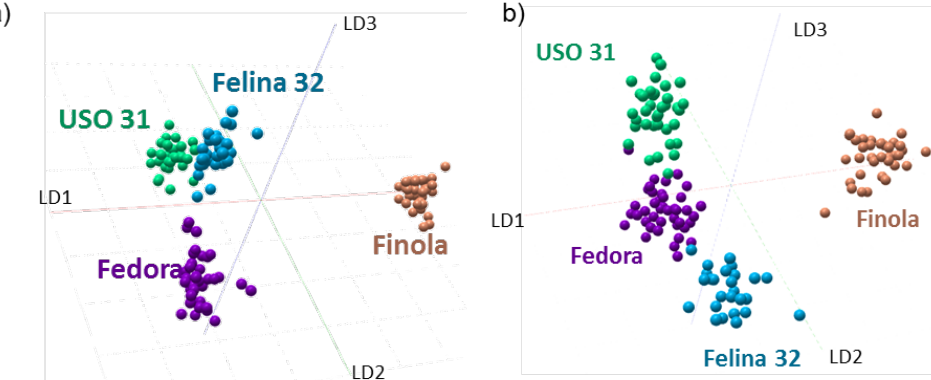
Figure 3. Multivariate statistical analysis of the molecular profiles from different plant organs com- bining all cultivars. ( a ) PCA plot and ( b ) PCA loading plot of 4 plant organs (flowers, bulbs, sugar leaves, and fan leaves) from all cultivars. ( c ) PC1 loading plot showing the highest variance between the flower (rose), bulb (purple), sugar leaf (blue), and fan leaf (green) due to the cannabinoid acid peak at m/z 357.2 and m/z 245.2 binned to 0.1 Da. ( d ) Relative intensity boxplots of the selected peaks showing the highest contribution to the variance of PC1. The intensities were normalized to the total ion chromatogram and represented as boxplots for each year with the Tukey method whisker defi- nition. There was a significant difference for m/z 357.2 between the flower (**** p = < 0.0001), bulb (**** p = < 0.0001), and sugar leaves (*** p = 0.0005) compared to fan leaves. The significant difference is also observed between the bulb and the sugar leaves (* p = 0.0341).